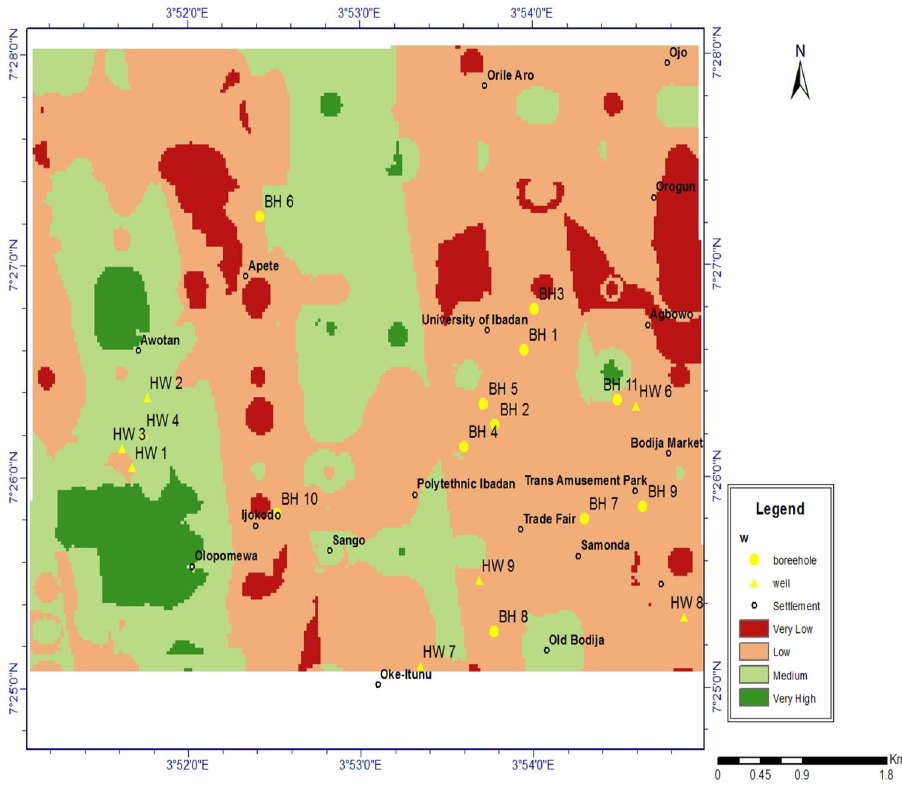
Table 5 Validation of groundwater potential map with borehole yield/hand-dug well data Borehole/hand-dug well number